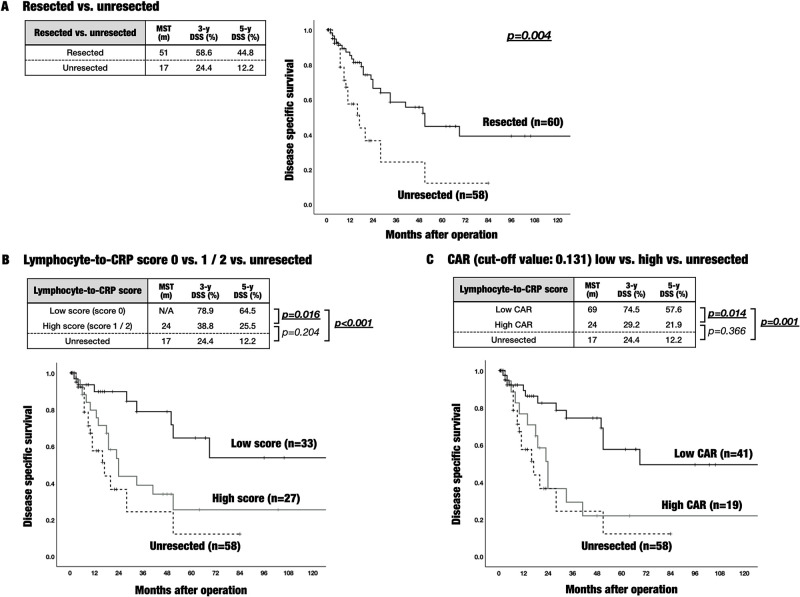
Comparison of DSS between resected patients allocated depending on lymphocyte-to-CRP score or CAR and unresected patient.(A) A comparison of DSS between sixty resected and fifty-eight unresected patients, who were out of surgical indication, for iCCA at our institution between October 2004 and April 2019. Unresected patients had significant poor DSS, compared with resected patients (p = 0.04). In unresected patients, the MST was 17 months, and 3-year / 5-year DSS was 24.4% / 12.2%, whereas in resected patients, the MST was 51 months, and 3-year / 5-year DSS was 58.6% / 44.8%. (B) DSS in patients with a low preoperative lymphocyte-to-CRP-score (score 0) was significantly better than in those with a high score (score 1 or 2) (p = 0.016). In the low score group, the MST did not reach 50% during 120 months, and 3-year / 5-year DSS was 78.9% / 64.5%. In contrast, the MST of DSS in high score group was 24 months, and 3-year / 5-year DSS were 38.8% / 25.5%. DSS in patients with a high lymphocyte-to-CRP score did not show statistical difference, compared with unresected patients (p = 0.204). (C) DSS in patients with a low CAR (< = cutoff value 0.131) was significantly better than in those with a high CAR (p = 0.014). Furthermore, DSS in patients with a high CAR did not show statistical difference, compared with unresected patients (p = 0.366). Abbreviations: DSS: Disease specific survival, iCCA: Intrahepatic cholangiocarcinoma, MST: Median survival time, CRP: C-reactive protein, CAR: CRP-to-albumin ratio.